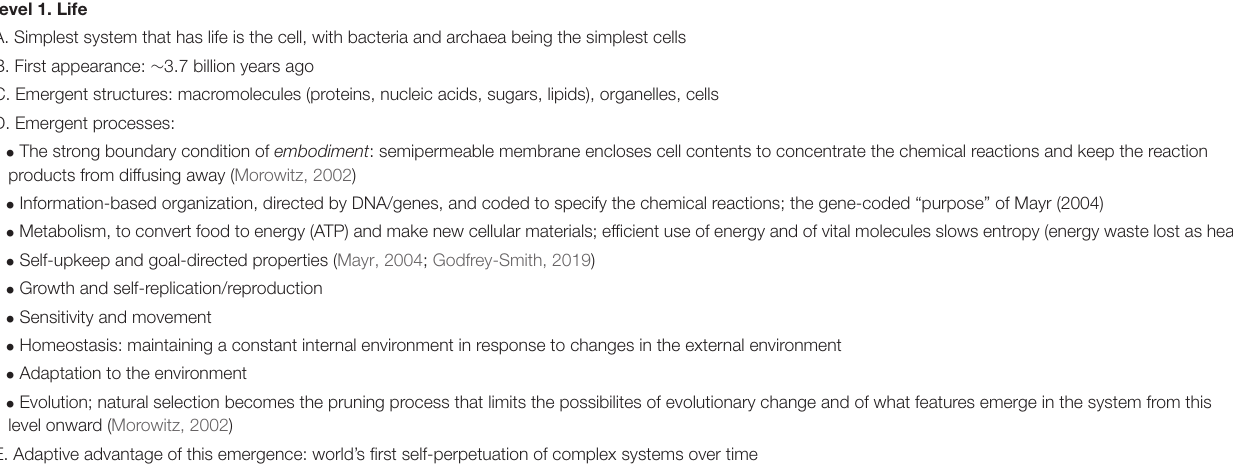
TABLE 2 | Three emergent levels in the evolution of consciousness, and the new features at each level (adapted from Feinberg and Mallatt, 2019). Level 1.